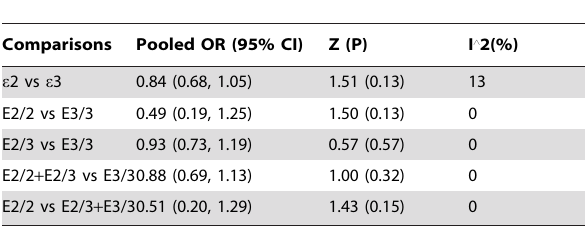
Table 1. Comparisons of E2 vs E3 in allele, genotype dominant and recessive models for GSD